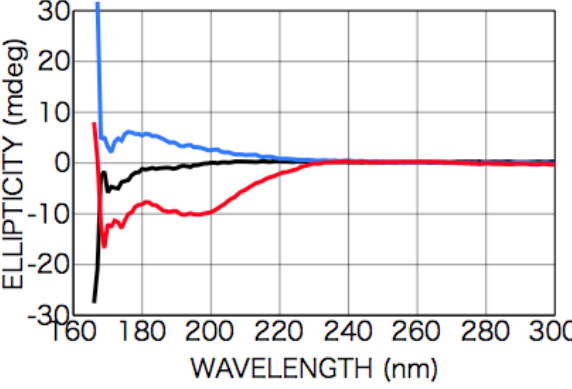
Figure 12. CD spectra of DL -isovaline films as deposited (black) (100-nm in thickness) and after CPL irradiation (colored). Left-handed CPL (blue); right handed CPL